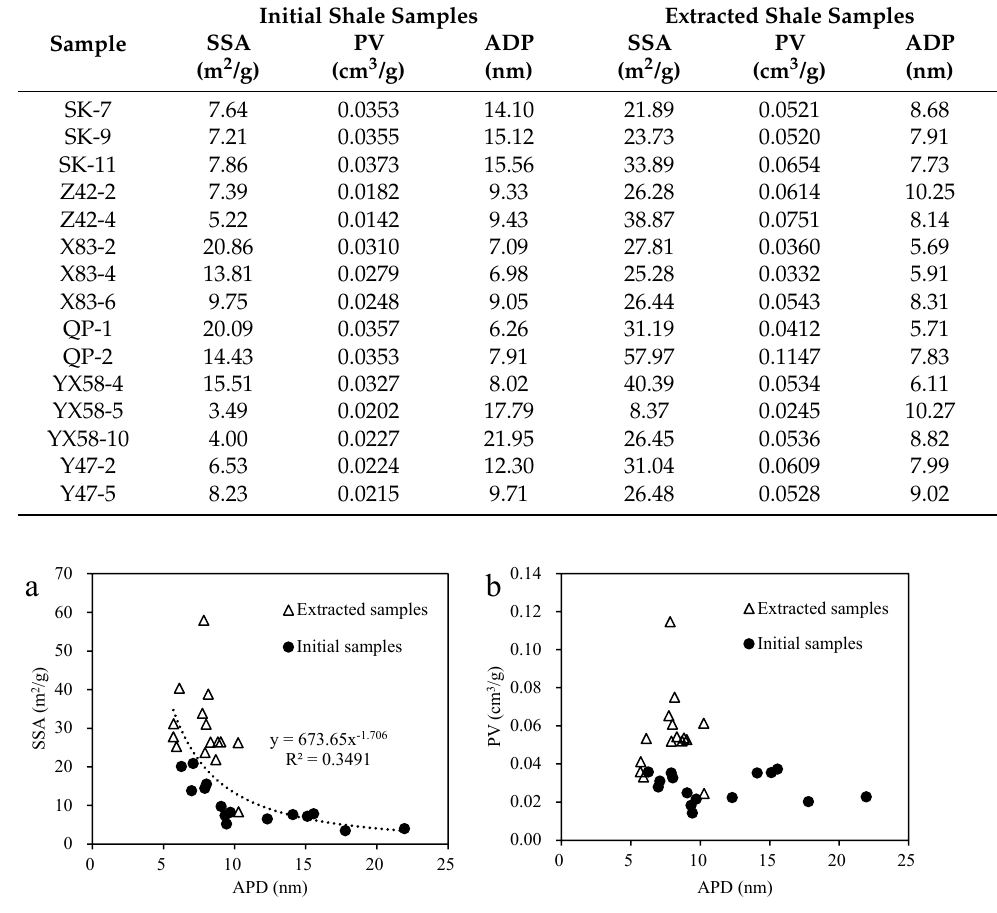
Table 3. Pore structure parameters of the initial and extracted shale samples.